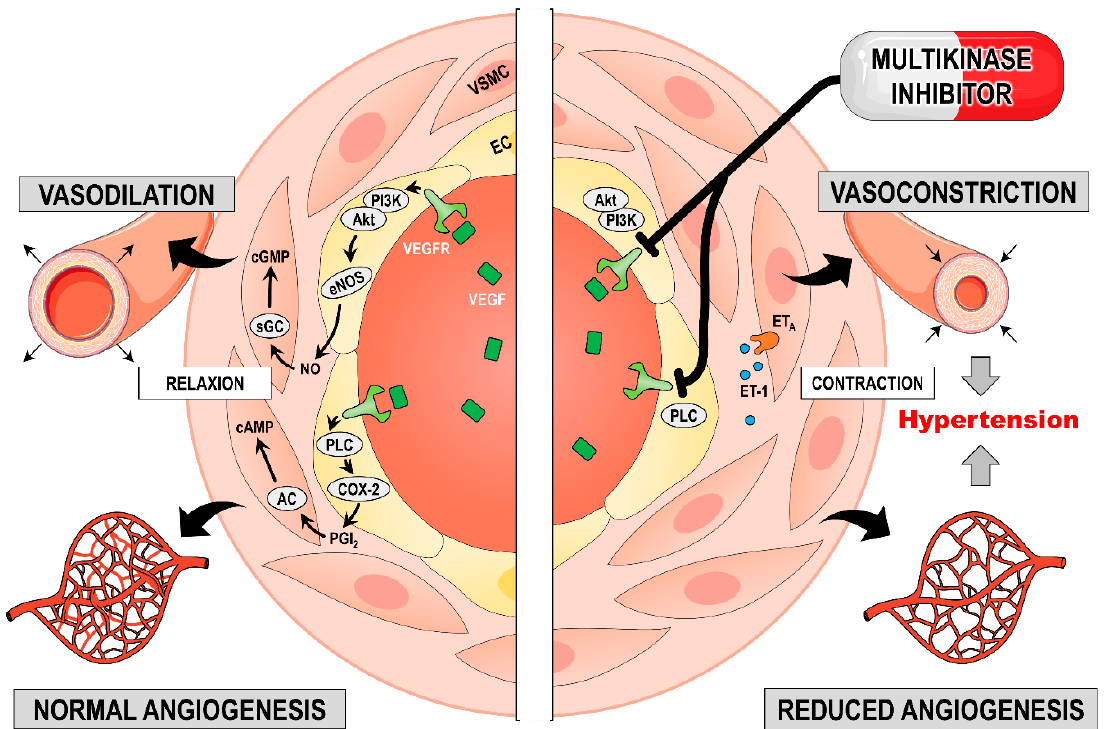
Figure 2. The effect of multikinase inhibitors (MKIs) on blood vessels to promote hypertension. The left panel mirrors the physiological condition and the right panel shows conditions during MKI therapy. Vascular endothelial growth factor (VEGF) binding to its receptor (VEGFR) activates phosphoinositide 3-kinase (PI3K); this binding stimulates endothelial nitric oxide synthase (eNOS) and thereby NO production. NO diffusion to vascular smooth muscle cells (VSMCs) activates guanylate cyclase (GC) to produce cyclic guanosine monophosphate (cGMP), and this action causes vessel relaxation. VEGFR also activates phospholipase C (PLC), which stimulates cyclooxygenase-2 (COX-2) to generate prostacyclin (PGI 2 ). This synthesis activates adenylate cyclase (AC) in the VSMCs and leads to cyclic adenosine monophosphate (cAMP) production, which causes vessel relaxation. Blocking VEGFR inhibits NO and PGI 2 synthesis and increases endothelin-1 (ET-1) production. This combination contracts VSMCs and promotes vessel rarefaction—a phenomenon that ultimately leads to hypertension. Additional abbreviations: EC (endothelial cell), ATP (adenosine triphosphate), GTP (guanosine triphosphate), ETA (endothelin receptor